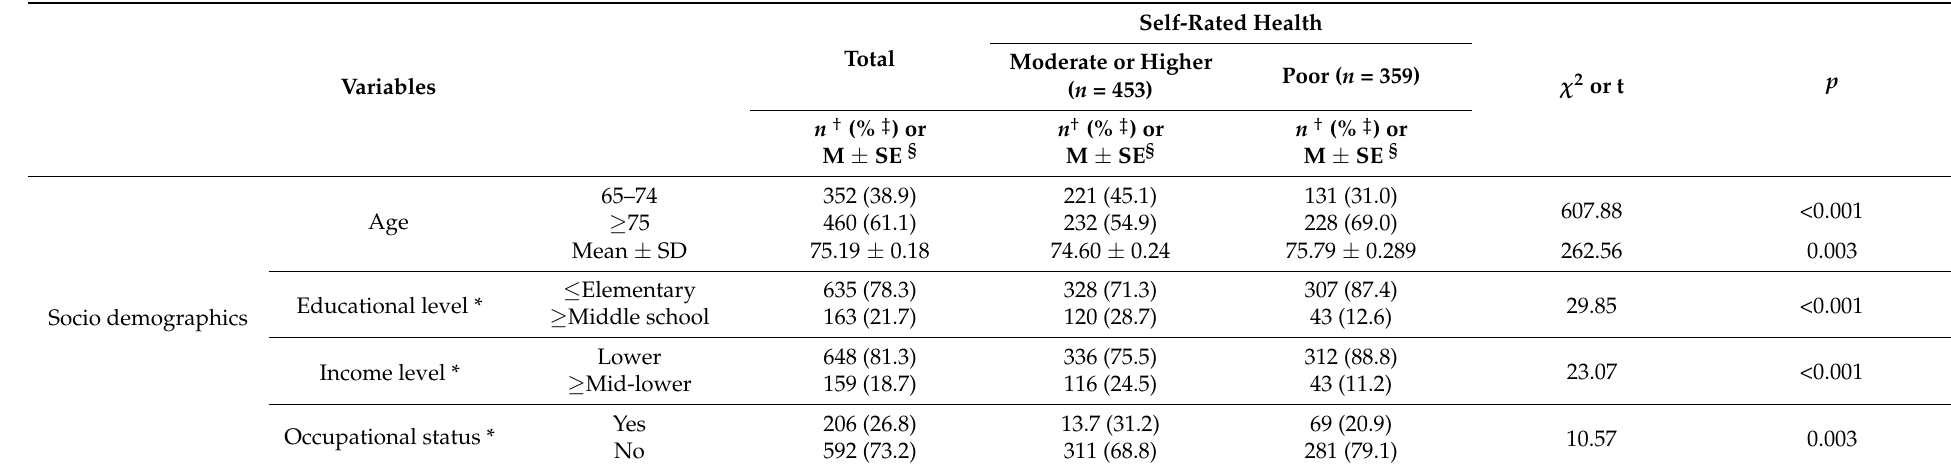
Table 1. Differences in self-rated health by sociodemographic characteristics.